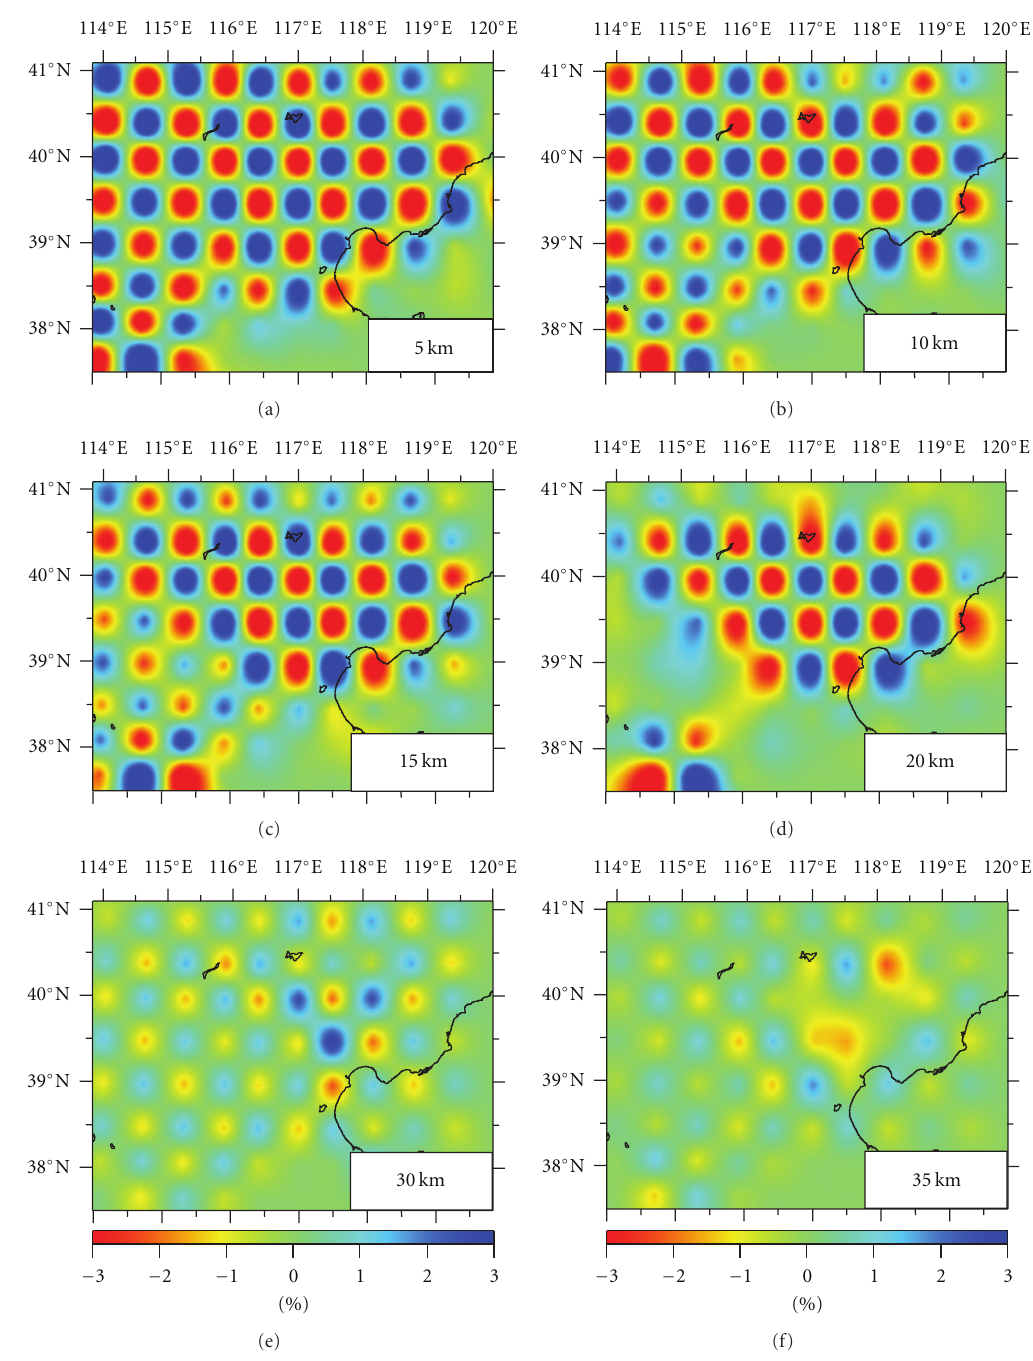
Figure 5: Results of checkerboard resolution test. The depth of the layer is shown on the right bottom of each map. The velocity perturbation scale (in %) is shown at the